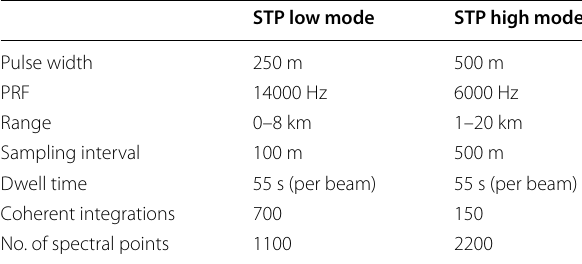
Table 2 Typical operating parameters for both low- and high-mode experiments